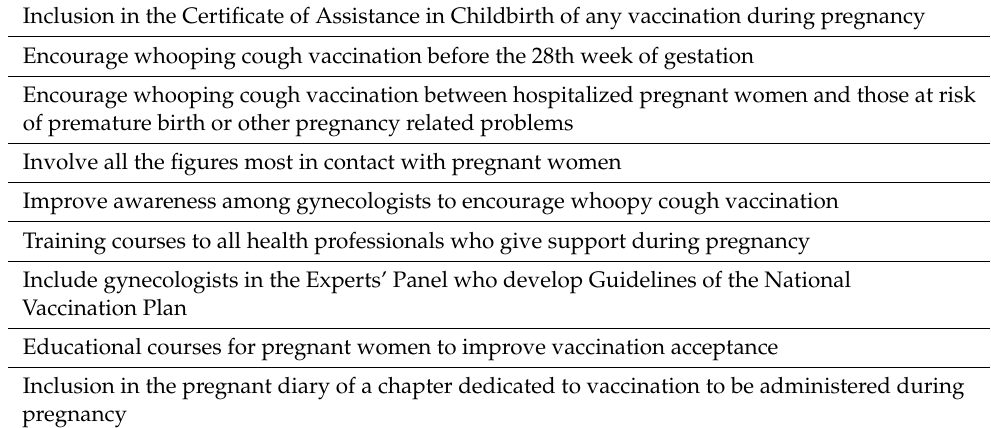
Table 2. Strategies to increase maternal